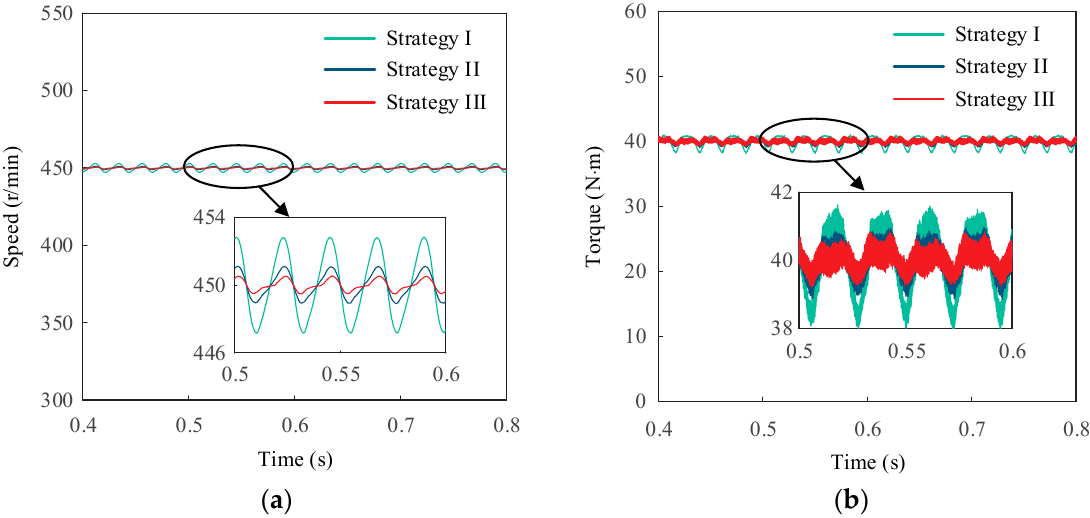
Figure 10. Simulation results of the three decoupling control strategies for faulty dual three-phase PMSM. ( a ) Speed. ( b ) Torque.